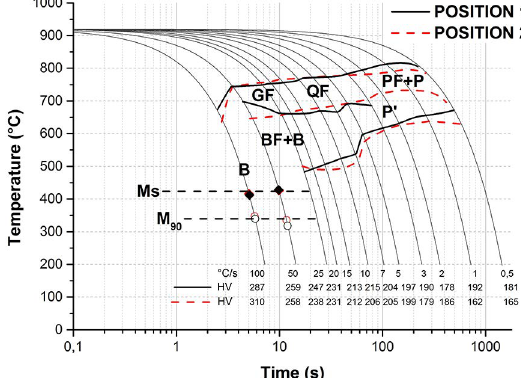
Figure 7. Comparison between CCT diagrams obtained for the C-Mn steel in position 1 and position 2. PF = polygonal ferrite; P = perlite; P’ = degenerate perlite; B = bainite; M = martensite; QF = quasipolygonal ferrite; GF = granular ferrite; BF = bainitic ferrite.